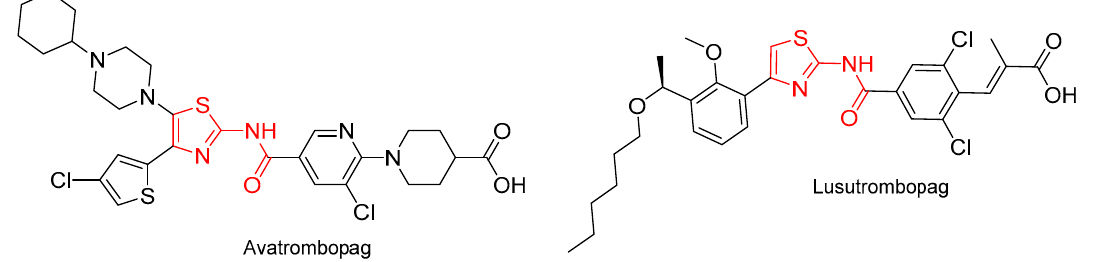
Figure 18. Structure of thiazol-2-amide (in red) containing molecules.